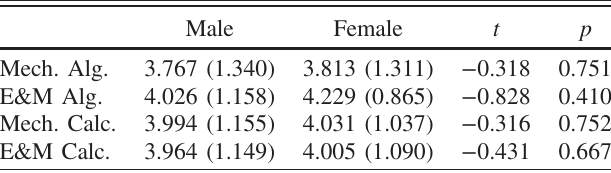
TABLE X. Average student feelings of inclusion (and standard deviation) for each course, as well as the t test and significance between these distributions.